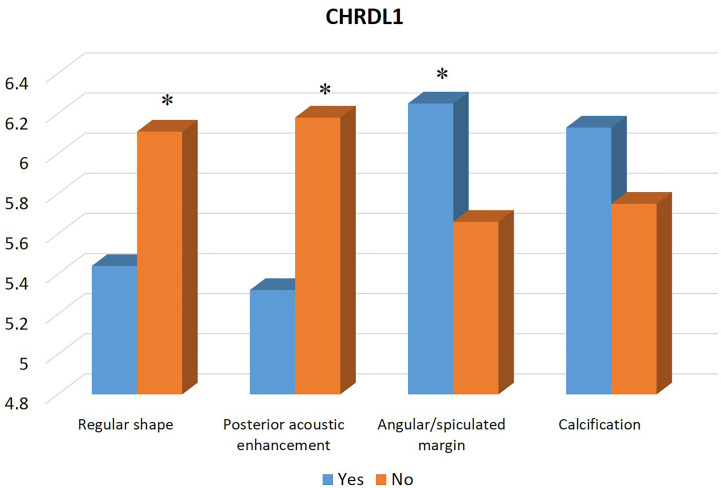
Association between the expression profile of mRNA CHRDL1 and sonographic features of TNBCs. The high expression of CHRDL1 is significantly associated with malignant sonographic features of irregular shape, absence of posterior acoustic enhancement, and presence of angular/spiculated margin. * indicates significant difference between the two groups with and without the specific sonographic feature.